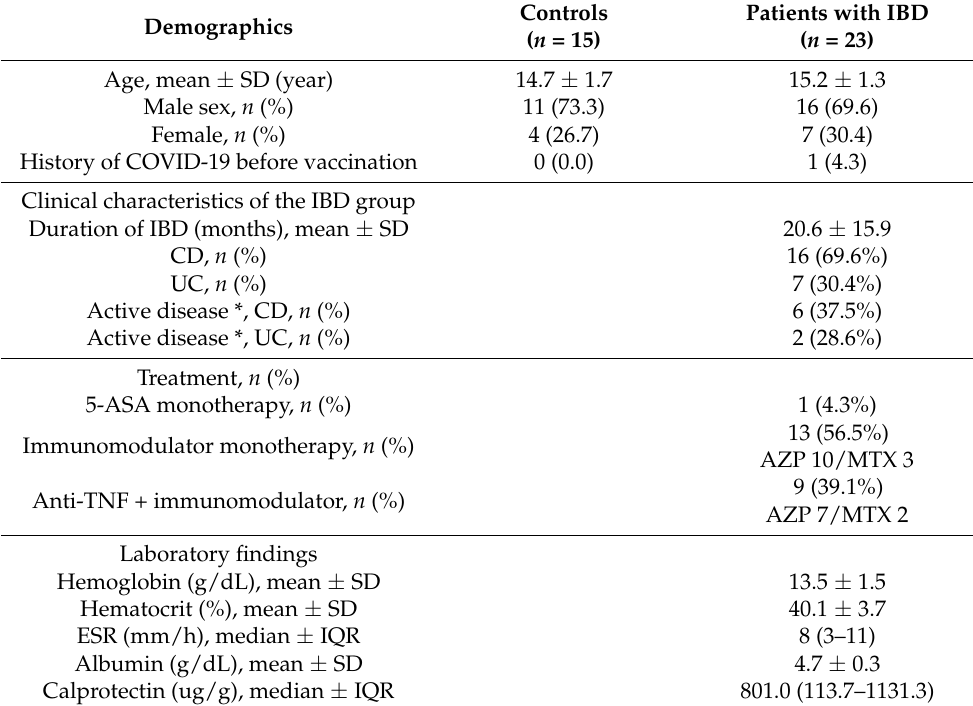
Table 1. Baseline characteristics of the subjects at the time of the